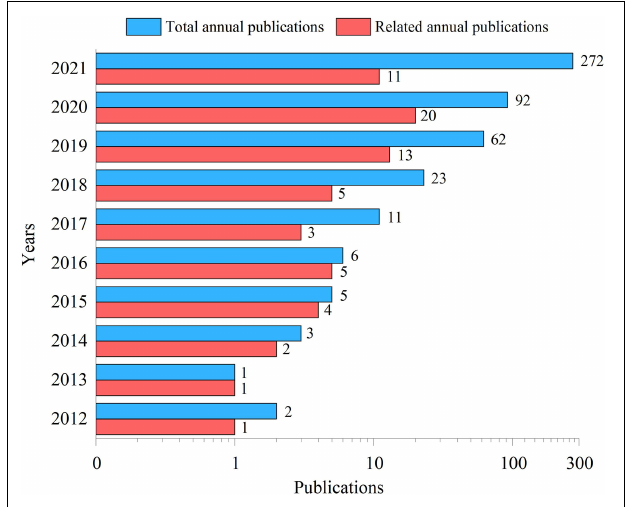
FIGURE 1 | Total annual publications and publications from 2012 to 2021 related to this manuscript indexed in Science Direct and Web of